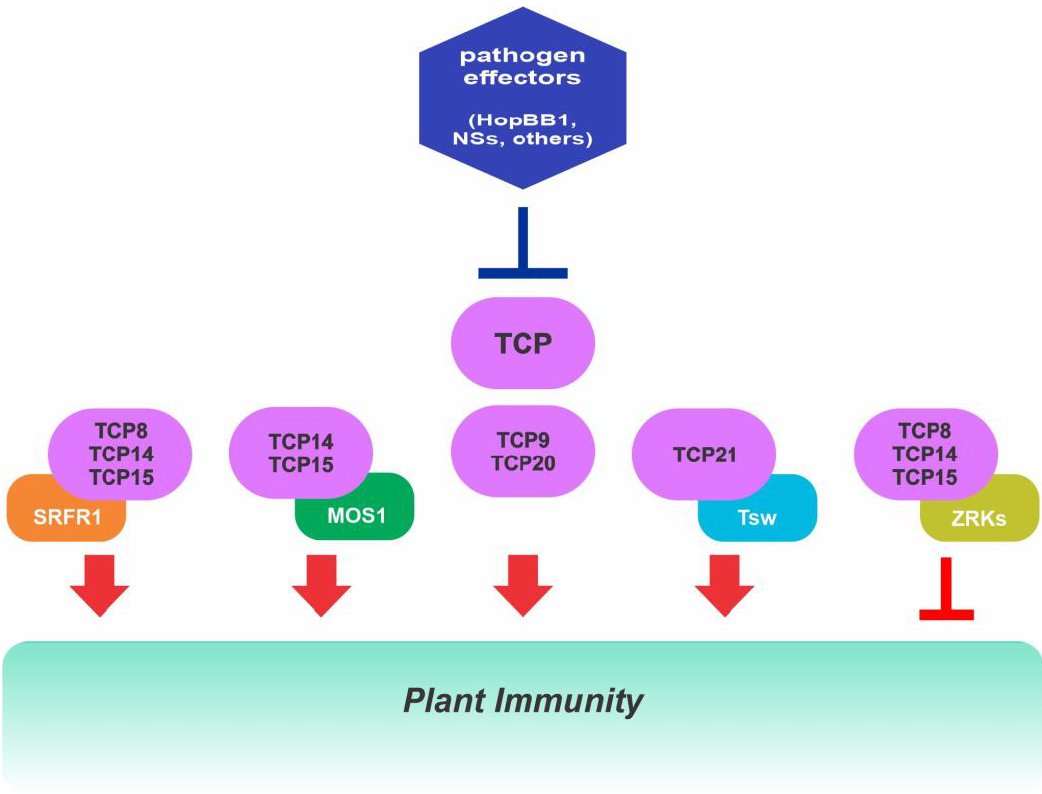
Figure 3. Class I TCP transcription factors play key functions in plant immunity against pathogens acting through different signaling networks. Class I TCPs from Arabidopsis interact with different proteins to modulate gene expression during pathogen infection and, in turn, are targeted by different pathogen effectors that affect their activity. See text for details.